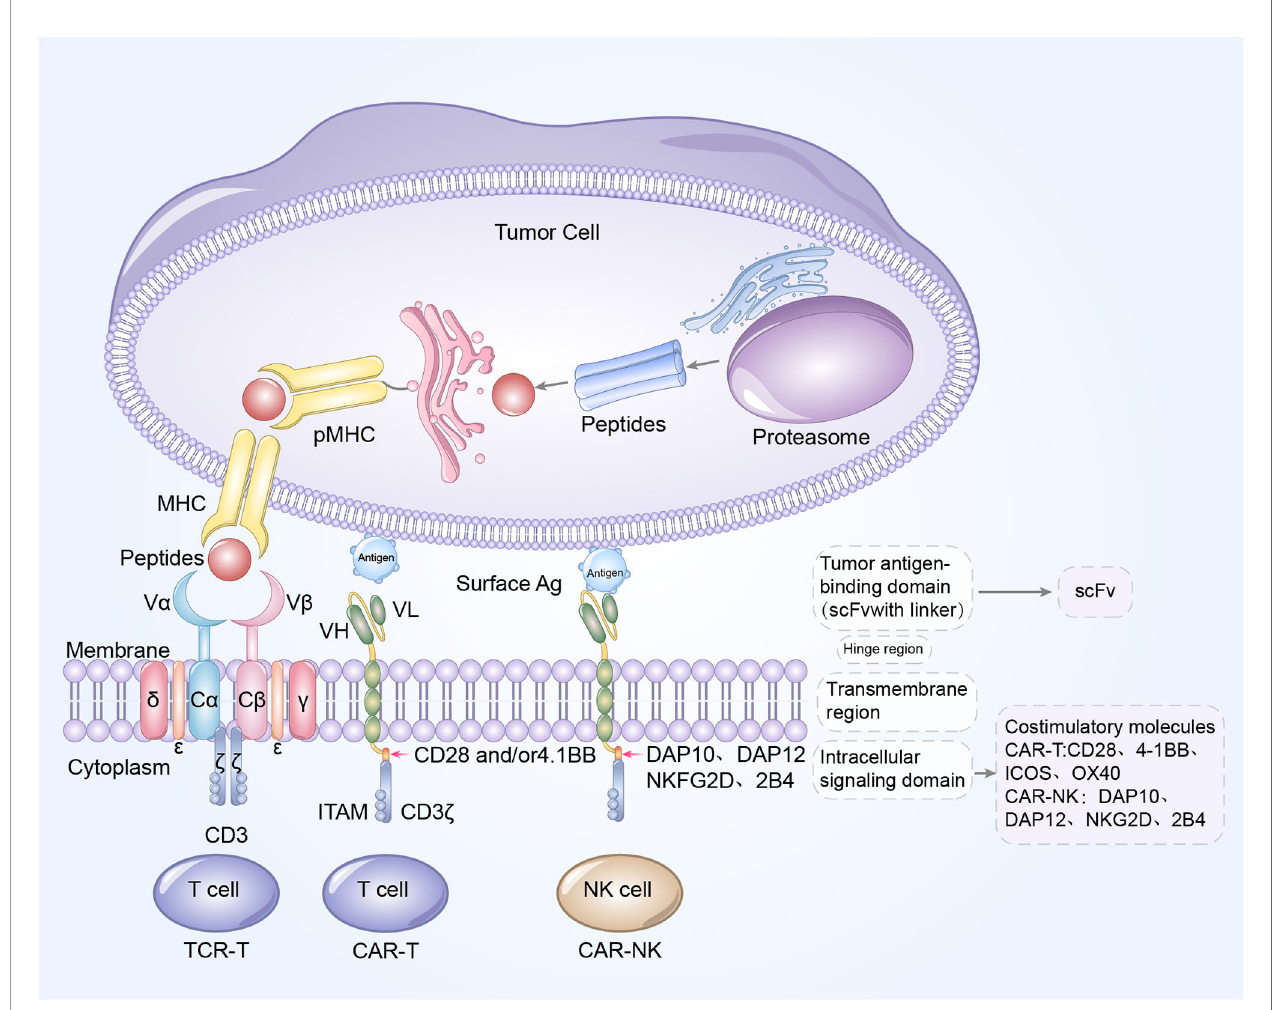
FIGURE 3 | Blueprint of CAR/TCR structure. Left to right: the designs of TCR-T cell, CAR-T cells, and CAR-NK cells. CAR-T cells and CAR-NK cells share a similar CAR structure, which is composed of extracellular tumor antigen binding domain (scFv), hinge region, transmembrane region and intracellular signaling domain. The update of CAR structures is primarily re fl ected in the incorporation of costimulatory molecules. CD28, 4-1BB, OX40 and ICOS are the common costimulatory molecules in CAR-T cells while DAP10, DAP12, NKG2D and 2B4 are widely used costimulatory domains in CAR-NK cells. The TCR complex is a heterodimer is constituted of TCR a and TCR b chains, noncovalently connected to the three CD3 dimers (CD3 g ϵ , CD3 d ϵ , and CD3 zz ). Antigen peptides from tumor cells bind to MHC molecules to form pMHC, and subsequently TCR recognizes and binds to the antigens presented by pMHC. The extracellular antigen signaling is transduced by TCR-CD3 complex into intracellular signaling, and mediates the elimination and killing of tumor